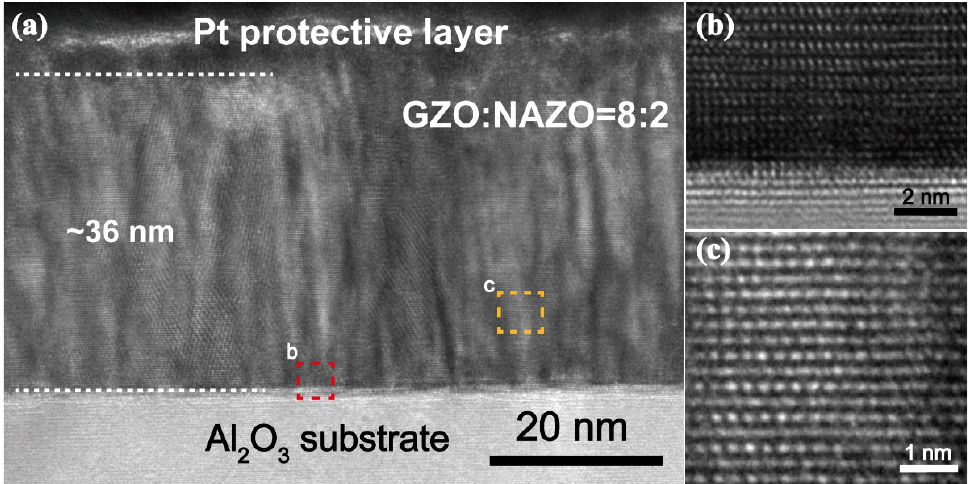
Figure 2. ( a ) Cross-section transmission electron microscopy (TEM) image of sample GZO:NAZO = 8:2; ( b , c ) are enlarged high-resolution TEM (HRTEM) images showing interfaces of Al 2 O 3 substate- GZO and GZO-NAZO, respectively, which are marked as “b” and “c” in ( a